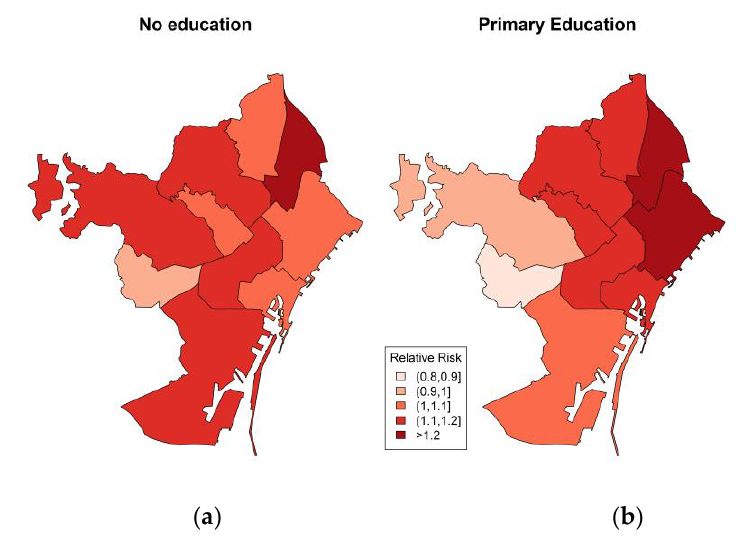
Figure 4. Relative risk of all-cause mortality related to summer extreme temperatures by district during the study period 1992–2015 in Barcelona with ( a ) no education and ( b ) with primary education.